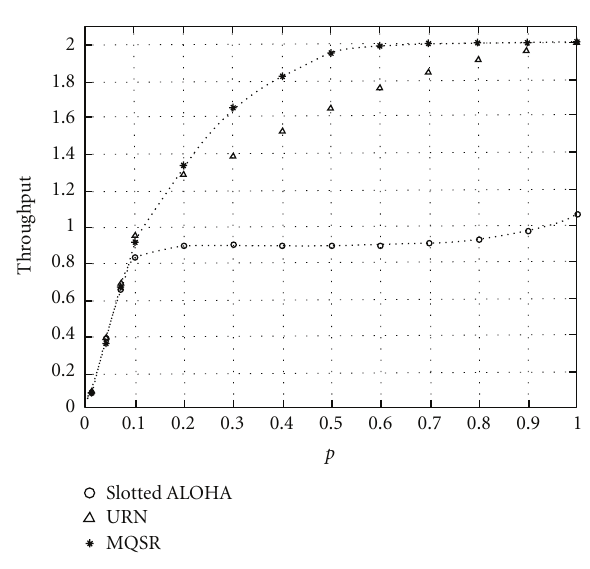
Figure 5: Throughput of